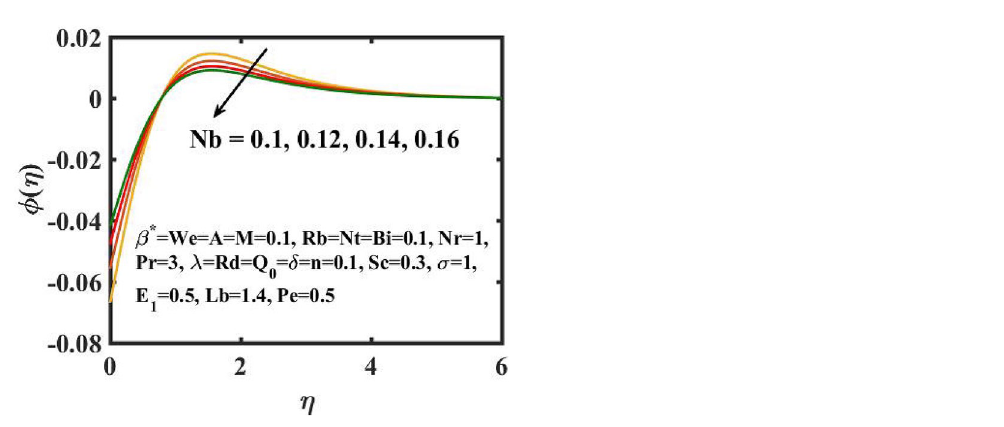
Figure 11. Encouragement of Nb on φ(η)